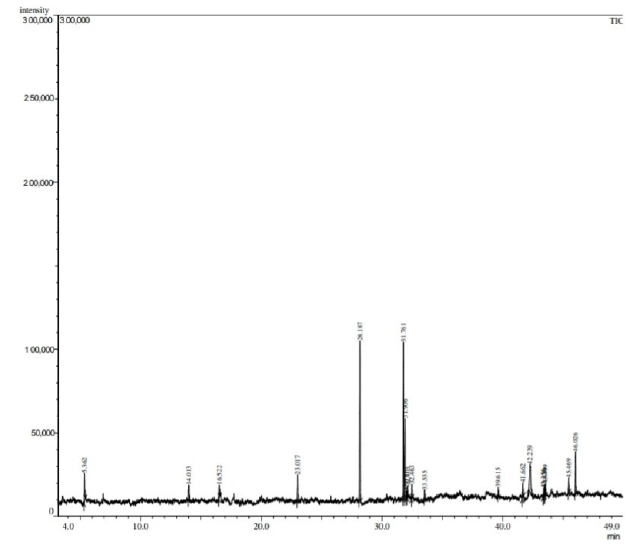
Figure 1. GC–MS analysis of LGBME.